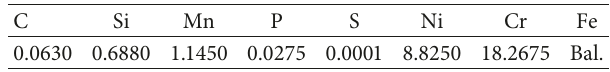
Table 1: Chemical compositions (wt.%) of A304 stainless